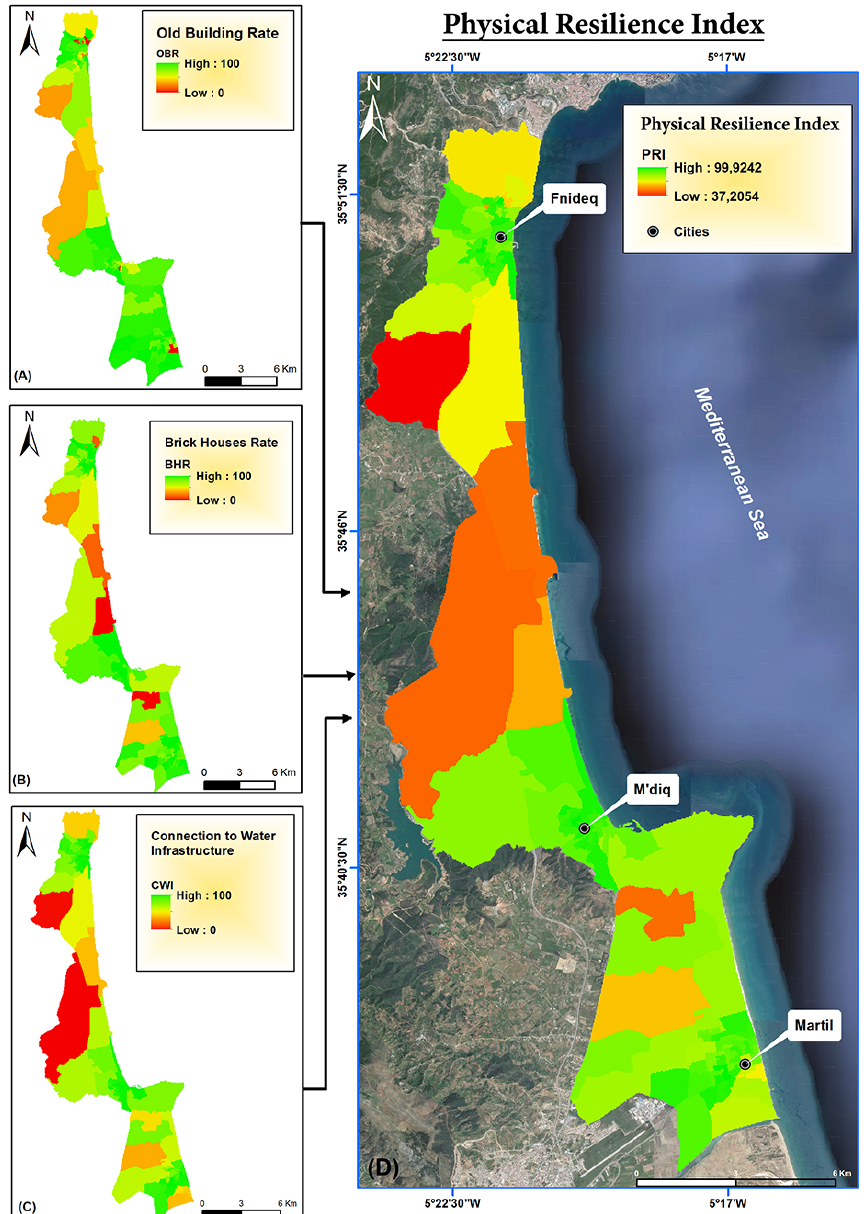
Figure 4. Spatial distribution of (a) old-building rate, (b) brick-house rate, (c) connection to water infrastructure, and (d) physical-resilience index (obtained from © Google Maps